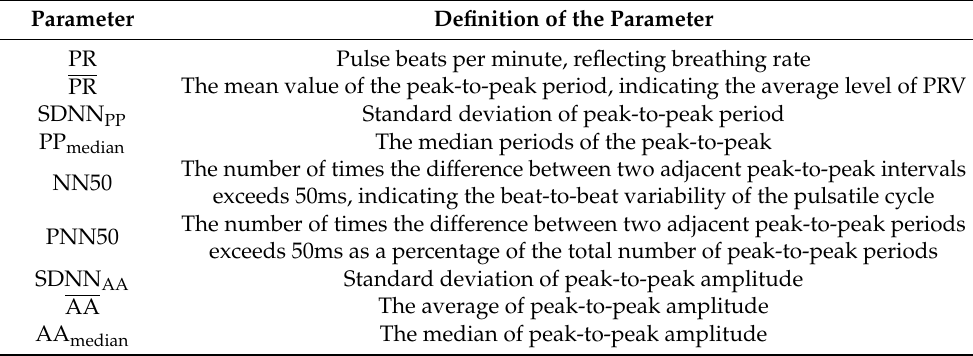
Figure 11. Actual detection effect of peak point detection. Table 1. The parameter definition extracted, based on PRV analysis.